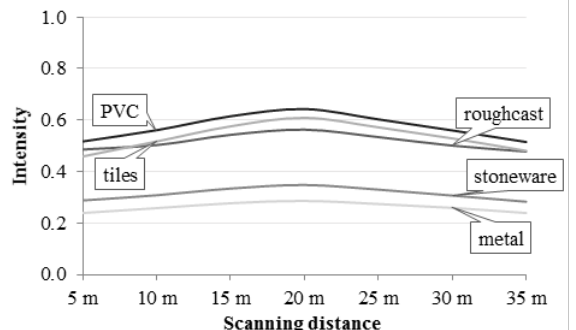
Figure 6. Relationship between the intensity of the returning signal as a function of the scanning distance for chosen test samples